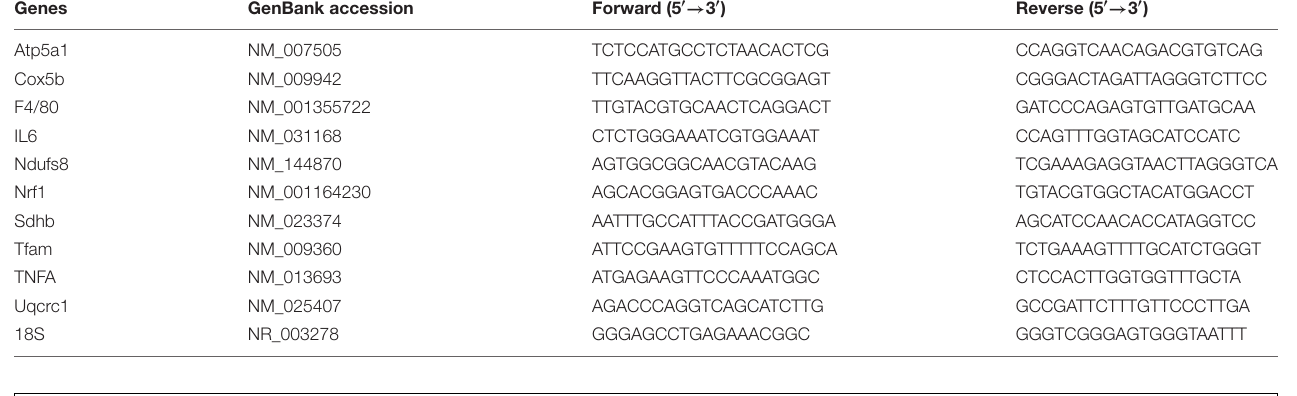
TABLE 1 | Real-time PCR primers.